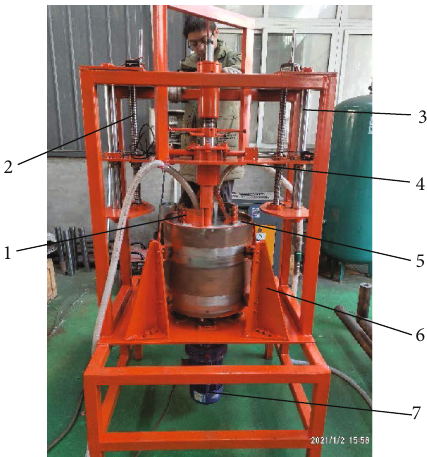
Figure 10: Experiment setup for bionic lateral PDC reamer bit. 1: bionic blade; 2: lift screw; 3: guide rail; 4: lift board; 5: concrete sample; 6: side supporter; 7: